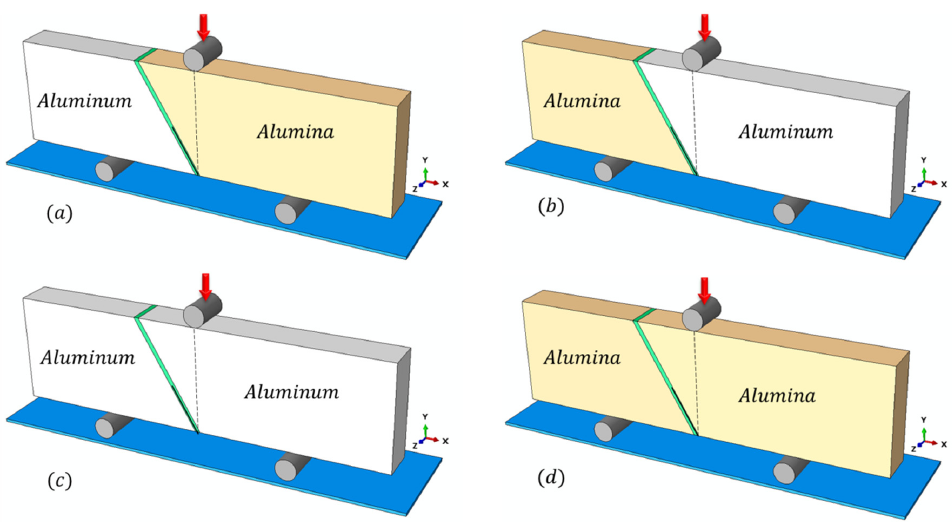
Figure 3. Four different permutations considered for the FE analyses of the BISBB specimen. ( a ) Al-Adhesive-Alumina, ( b ) Alumina-Adhesive-Al, ( c ) Al-Adhesive-Al, ( d ) Alumina-Adhesive-Alumina.